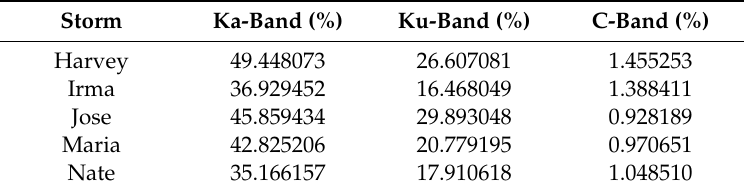
Table 3. Percentage of Rain Contamination (Serious and Side Lobe) using 5.5 km